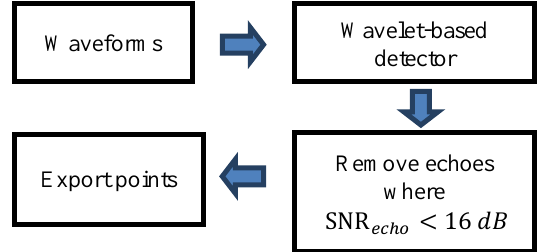
Figure 10. Flow chart of the wavelet-based detection method